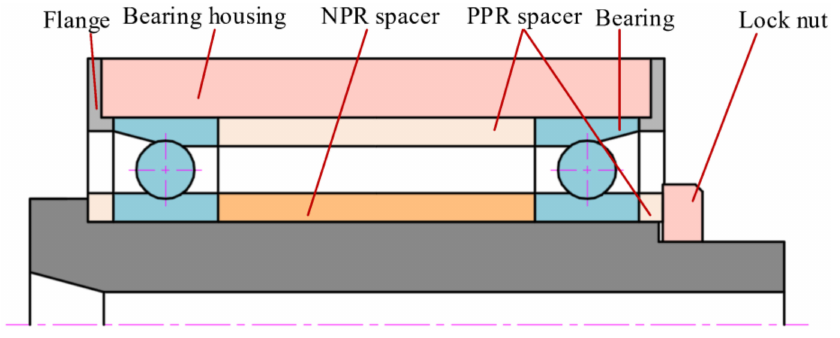
Figure 1. Schematic of spindle